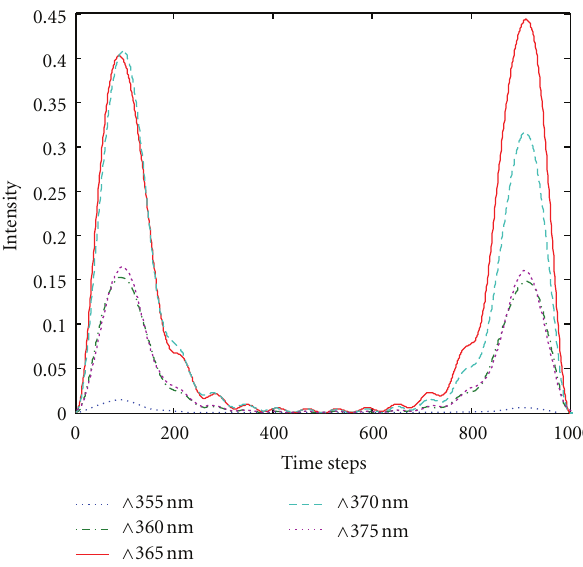
Figure 4: Energy flow of GaN at di ff erent grating